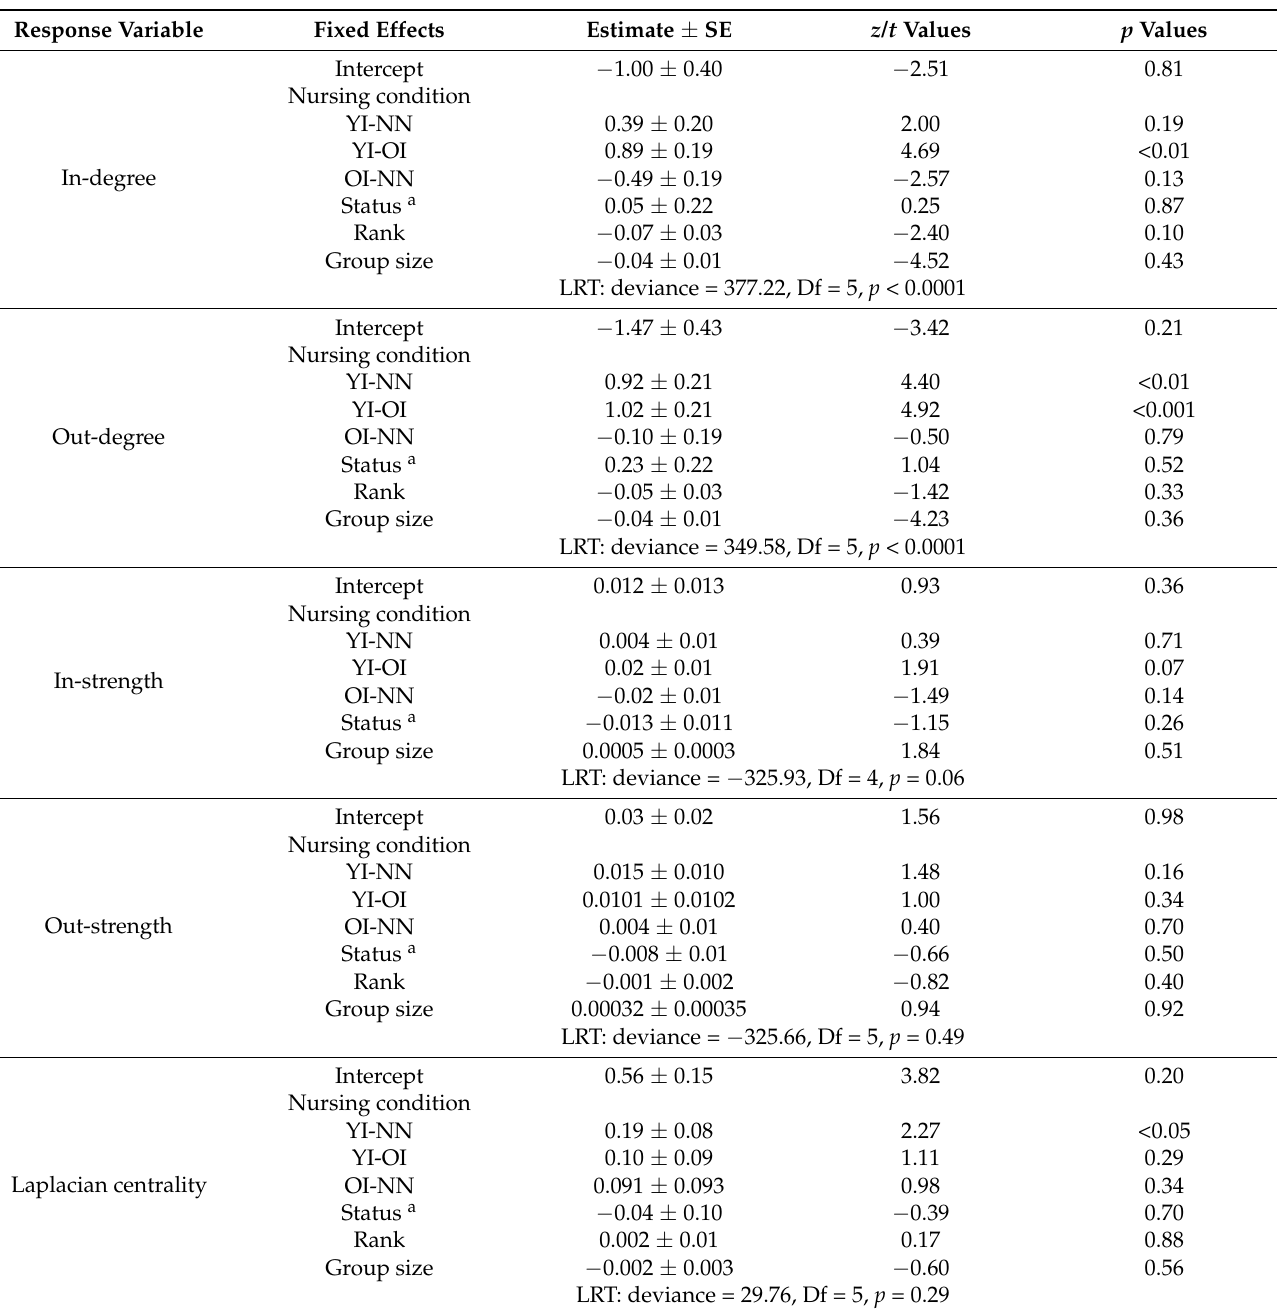
Table 2. Grooming network. Generalized linear mixed models (mixed binomial (in-/out-degree) or gaussian (in-/out- strength and Laplacian centrality) regressions) of SNA grooming metrics, testing the main fixed effects of nursing condition (YI vs. OI vs. NN females), and the controlled predictors (i.e., fertility status (intact vs. sterilized females), group size and hierarchical rank): coefficient estimates, standard errors, z -test (for in-/out-degree) or t -test (for in-/out-strength and Laplacian centrality) and p -values, and likelihood ratio tests (LRT). The reference category for the nursing condition is the first condition stated. a “Intact females” as a reference category for the fertility status. The lowest values of the hierarchical rank represent the highest-ranked